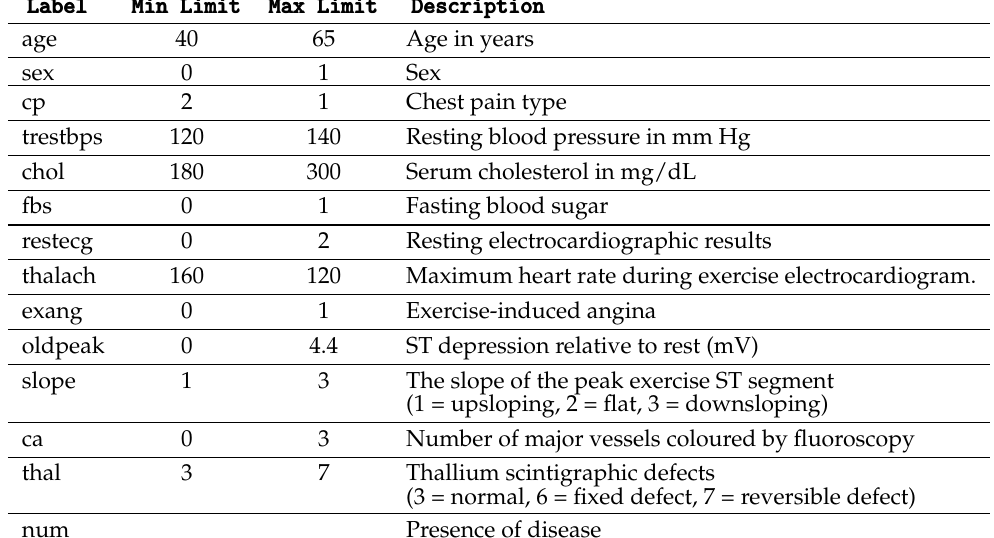
Table 3. The 14 attributes of the processed Cleveland Heart Disease dataset with their specified limits. More details on the attributes in Section 6.1 and details on maximum and minimum limit in Section 6.2. Label Label